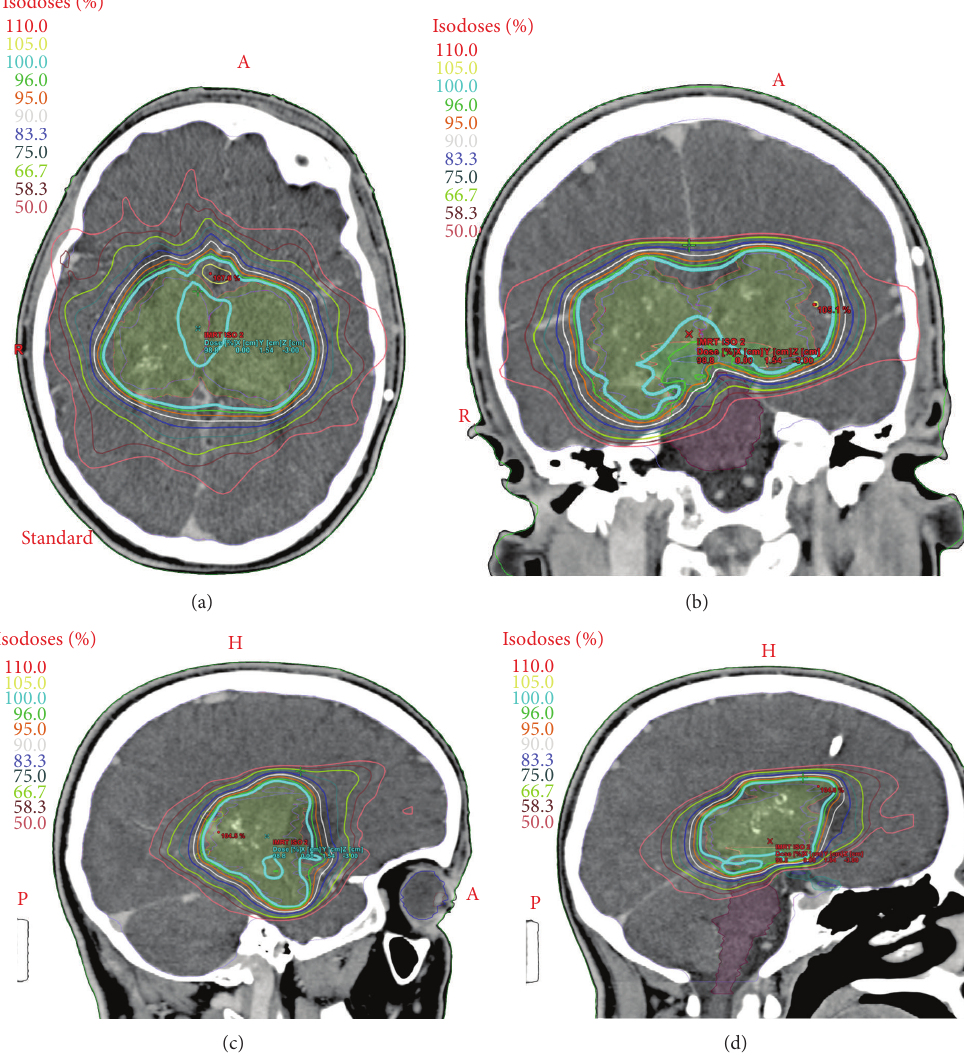
Figure 4: Stereotactic treatment plan. (a) Axial. (b) Coronal. (c) Sagittal left. (d) Sagittal right.